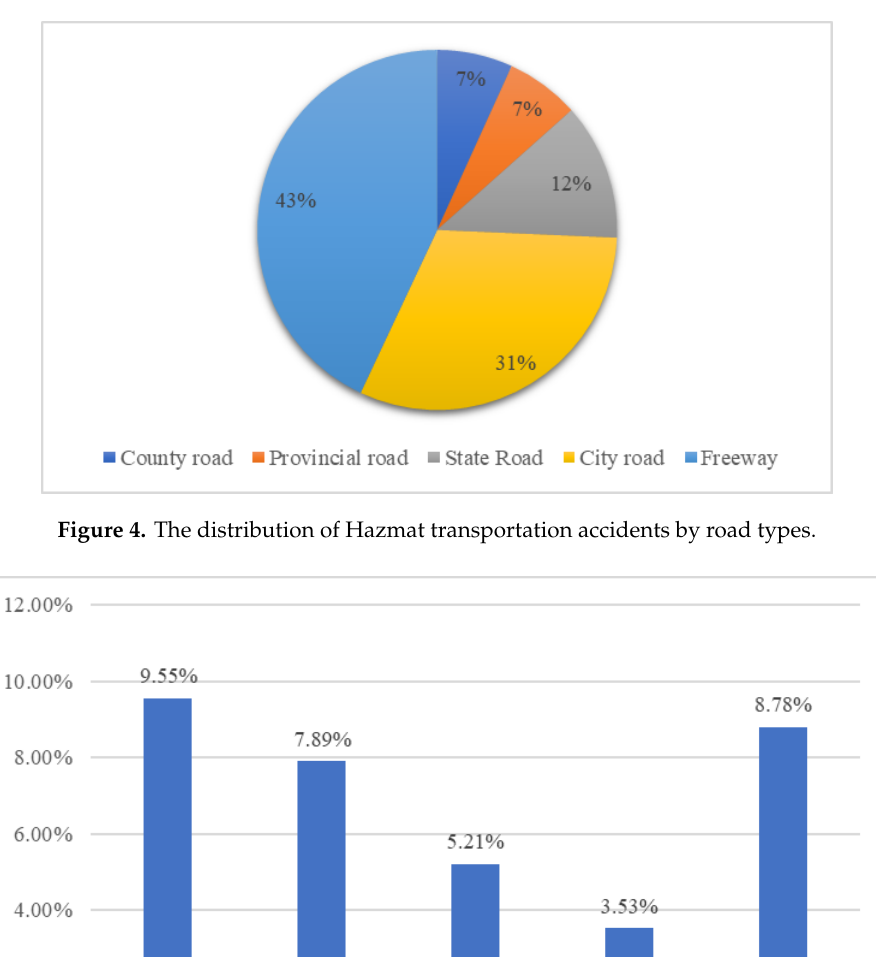
Figure 4. The distribution of Hazmat transportation accidents by road types.